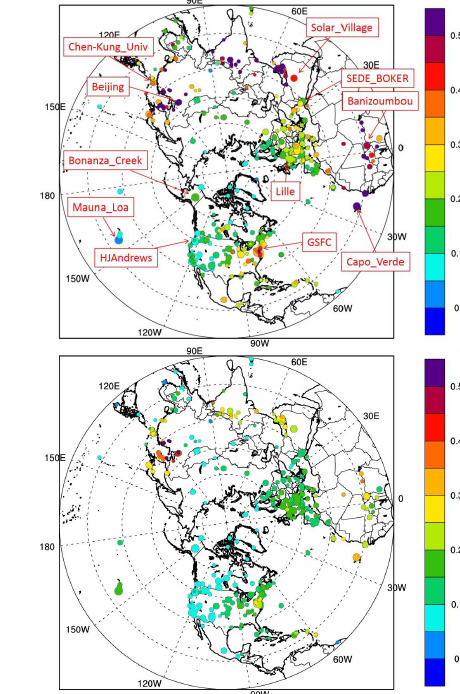
Figure 4. Comparison of spatial distributions of summer AOD be- tween AERONET and WRF-CMAQ (dot size indicates the extent of data coverage for the period 1990–2010; all converted into 533nm; sites marked by red boxes are selected for trend